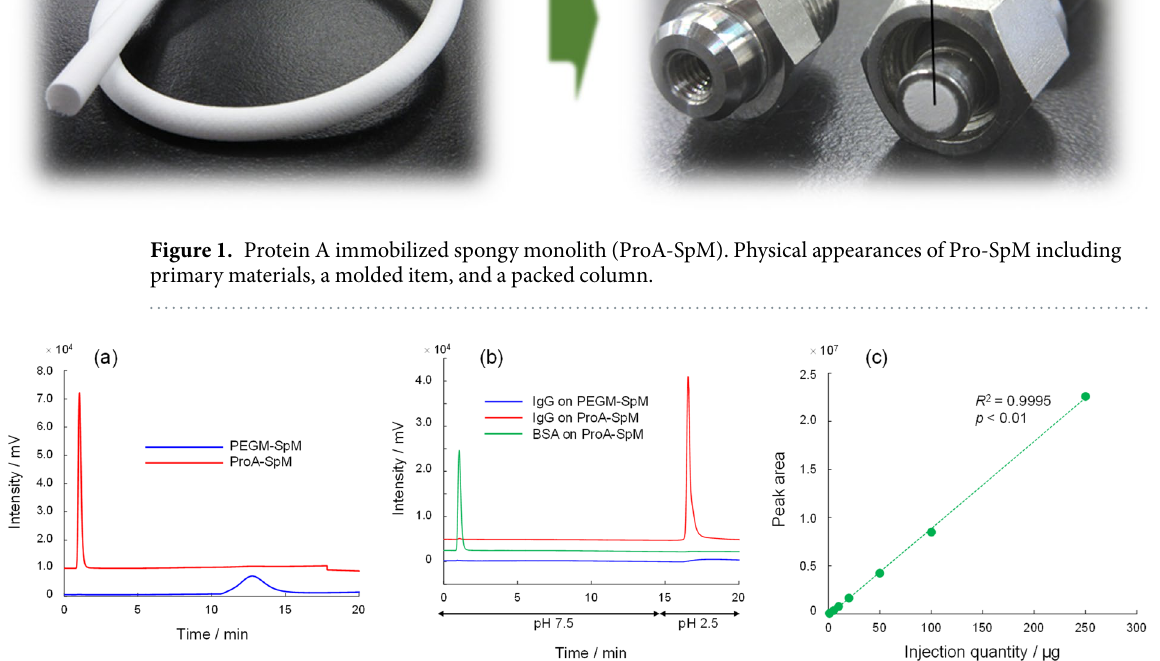
Figure 2. UV Chromatograms of IgG and BSA on the PEGM-SpM and ProA-SpM. ( a ) Reversed-phase chromatograms of IgG-1 with the PEGM-SpM and ProA-SpM. ( b ) Affinity separation of IgG-1 by a stepwise pH gradient. ( c ) A relation between the injected amount of IgG-1 and the peak area with the